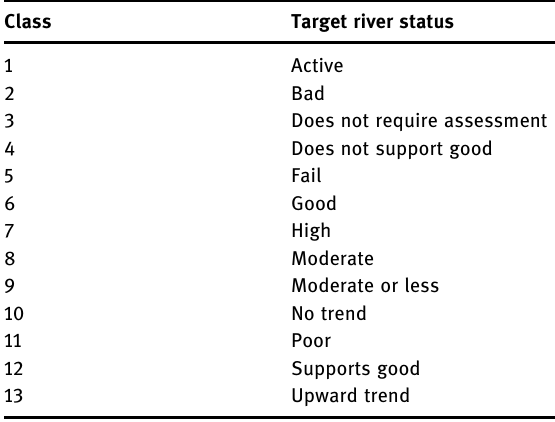
Table 1: Multivariate class labels of the RBD